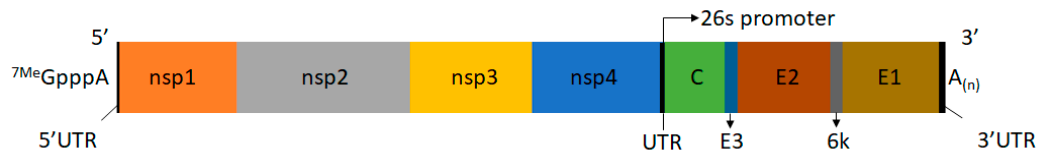
Figure 3. Organization of VEEV genome . VEEV genome is a single-stranded positive-sense RNA of 11.4kb length. VEEV encodes four nonstructural proteins (nsP1, nsP2, nsP3 and nsP4) and five structural proteins (capsid (C), envelope (E) 3, E2, 6k, and E1). VEEV genome has mRNA characteristics. 5’ untranslated region (UTR) is capped with methyl residue present on the 7-position of capping guanosine nucleotide. A short UTR is present after the nsp4 gene sequence that has a promoter sequence for a 26S subgenomic RNA. There are two open reading frames (ORF) in the genome. The first ORF in the 5’ region translate nonstructural proteins and the second ORF in sub genomic RNA translate structural proteins. 3’ end of the genome has a poly(A) tail.